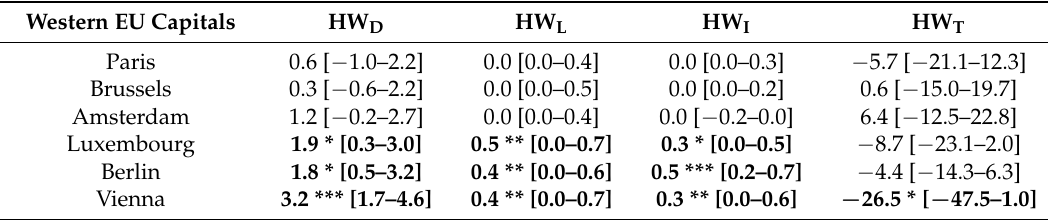
Table 2. Trend slopes (5-year change), statistically significant changes and 95% confidence interval (square brackets) of the heatwave hazard characteristics (HW D : heatwave days; HW L : long heatwaves; HW I : high-intensity heatwaves; HW T : the timing of the first simultaneously long and high-intensity heatwave) in western EU capitals. Significant trends are shown in bold.